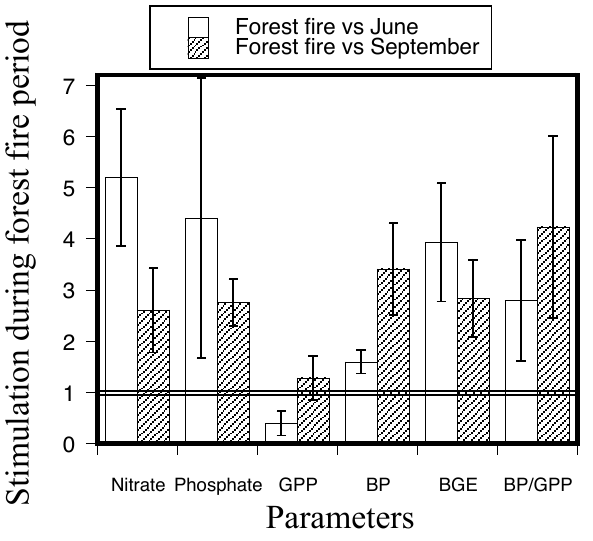
Fig. 5. Stimulation of nutrients and biological parameters during the forest fire period (July–August 2003). Simulation was calculated as ratio of values from the forest fire period vs the period before (June) or afterwards (September). The double line indicates zero stimula- tion. Standard errors were calculated from the 3–7 depth-averaged values obtained during the forest fire period and are shown as er- ror bars. Nitrate and phosphate data from the upwelling event early July 2003 were excluded. Mann-Whitney test statistics showed that nitrate and phosphate concentrations were significantly higher in July–August than in June and September ( P < 0 . 05). For the other parameters, not enough data points were available for performing statistical tests. GPP, gross primary production; BP, bacterial pro- duction; BGE, bacterial growth